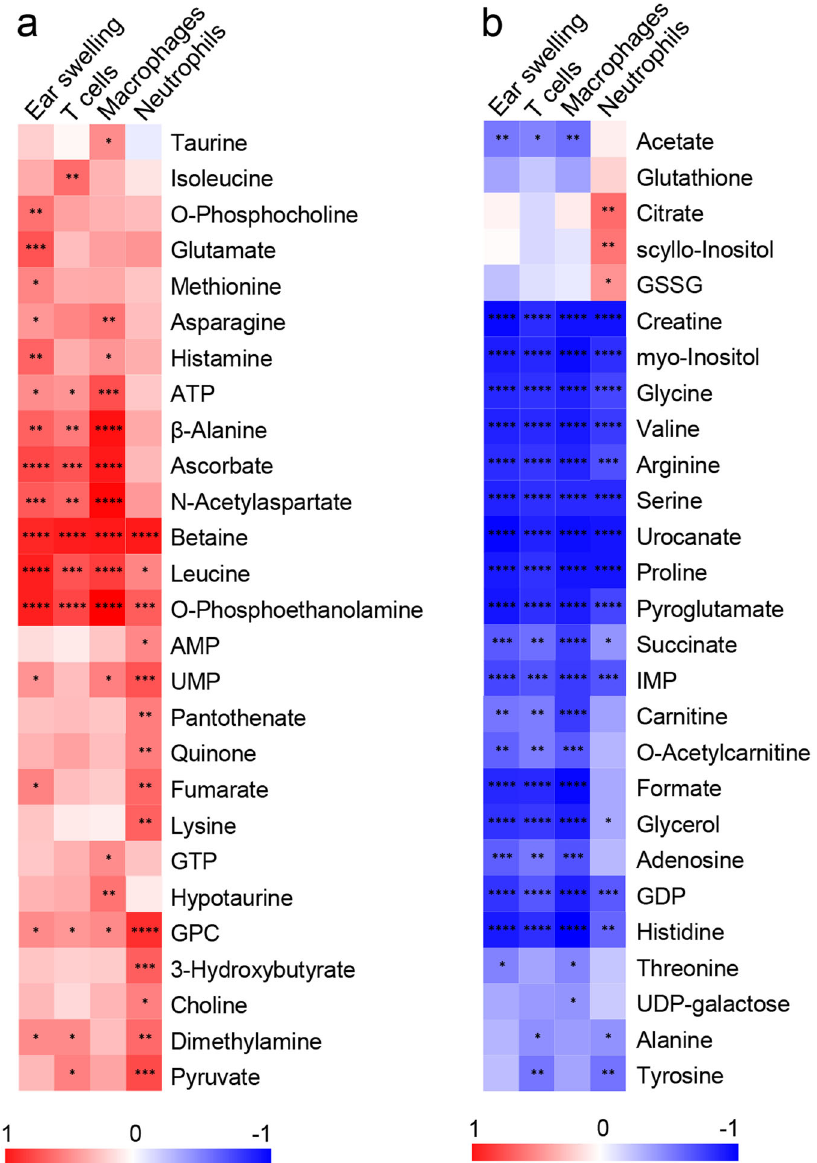
Fig. 4 Ear swelling and immune parameters correlated to the metabolite concentrations during acute and chronic cutaneous DTHR. Ear swelling thickness, T cell (CD3), macrophage and neutrophil epidermal in fl ammation scores were correlated to metabolite concentration changes over the whole experimental setup, showing autoscaled ( − 1; 1) ( a ) positive (red) and ( b ) negative (blue) correlation with correlation coef fi cient statistical signi fi cance P values: ****<0.0001, ***<0.001, **<0.01, *<0.05, based on Pearson r distance measure ( n = 5